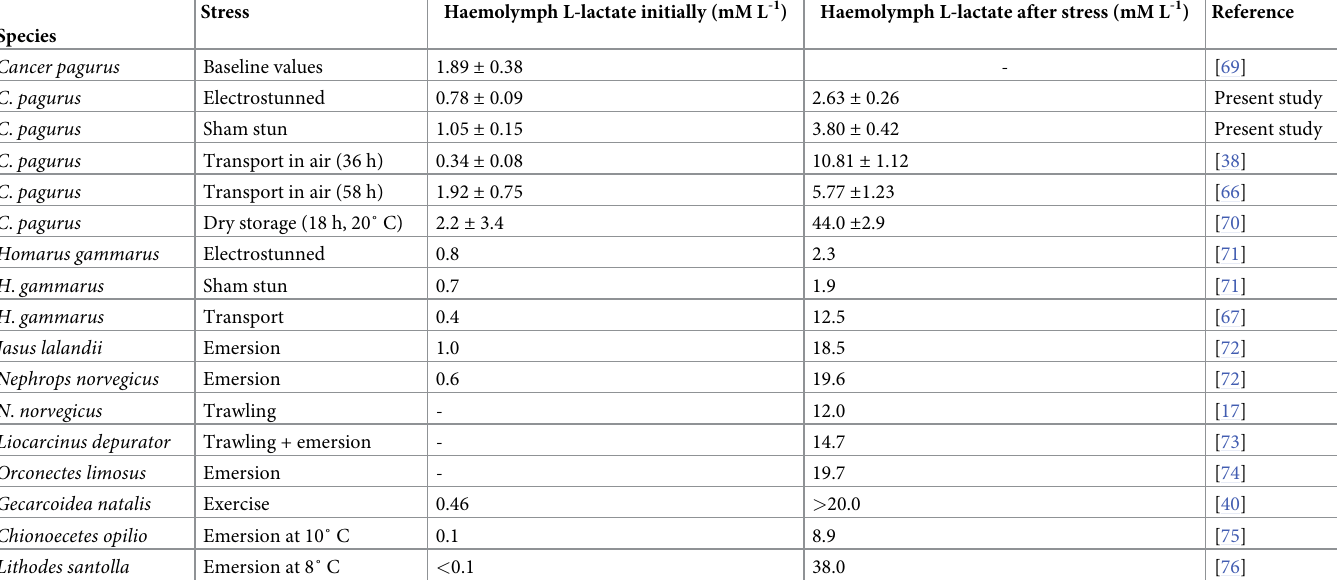
Table 1. Haemolymph L-lactate concentrations measured in decapod crustaceans in response to various